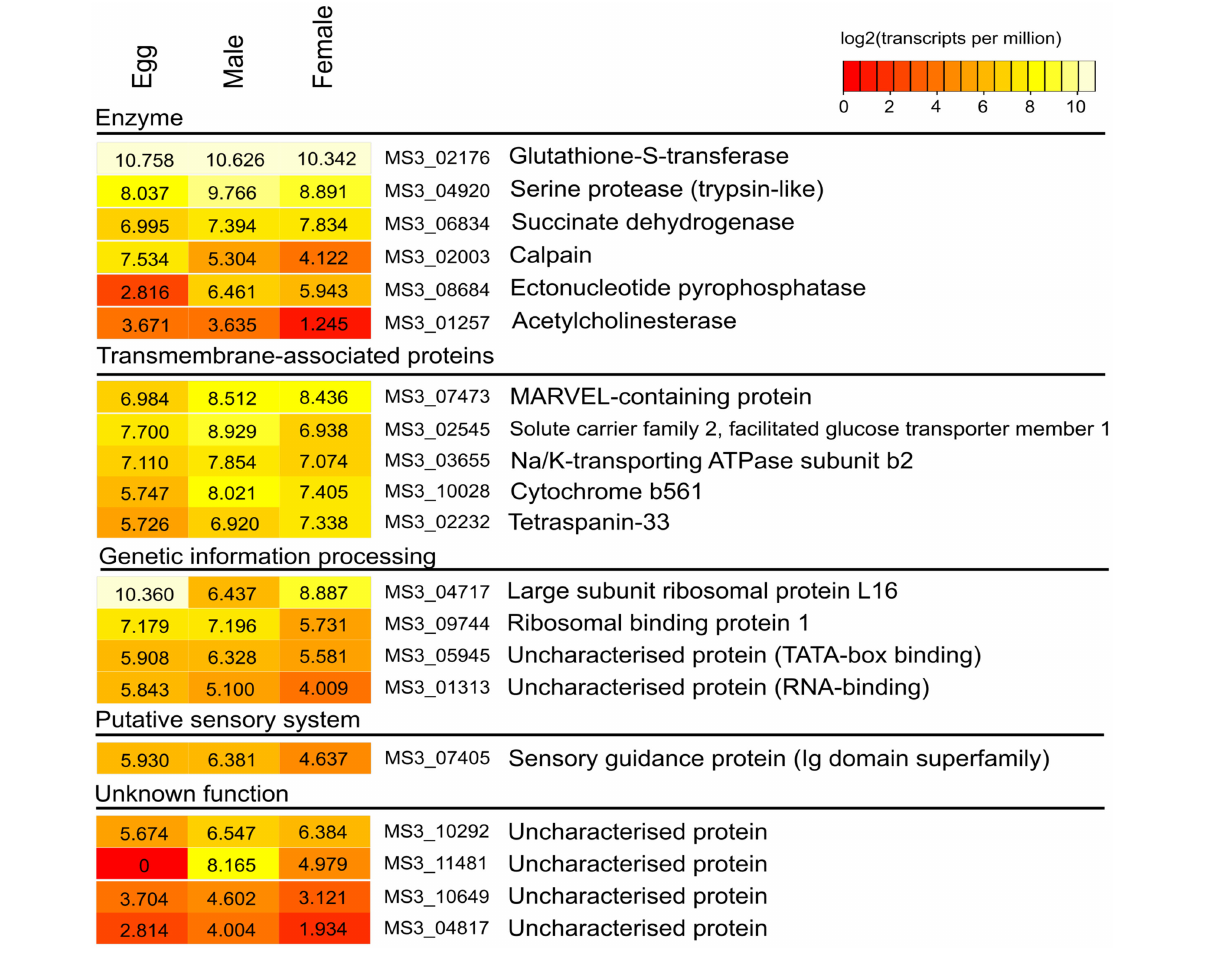
reading frames of the published gene set (7) using Bowtie (v2.1.0) (9). Normalized levels of gene transcription were calculated using the software package RSEM (v1.2.11) (10) and reported as the numbers of transcripts per million reads sequenced (TPMs). The TPM value of each gene was log 2 -transformed and subjected to heat map visualization using